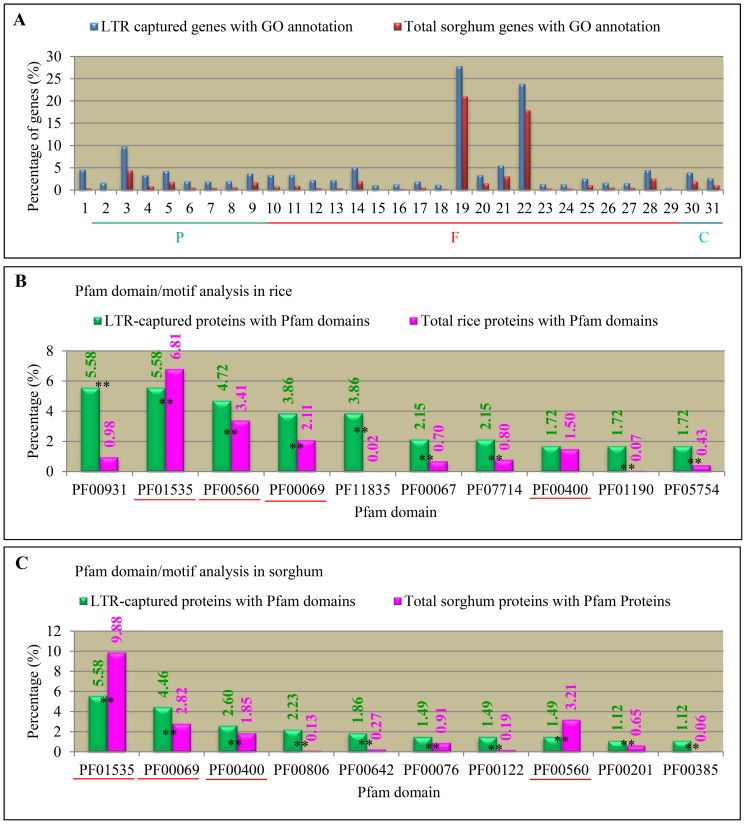
Gene set enrichment analysis and Protein domain analysis in LTR retrotransposon captured genes.(A) Gene set enrichment analysis in sorghum. Blue and red columns indicate the percentages of this GO term in all LTR captured sorghum proteins and in total annotated proteins, respectively. The percentage is calculated as the frequency of the total numbers of each GO term in all LTR captured proteins with GO term assigned or in all annotated proteins with GO term assigned. “P”, “F” and “C” in (A) indicate GO three categories biological process, molecular function and cellular component, respectively. GO term annotation in (A) was shown below: 1, DNA integration; 2, reproductive cellular process; 3, DNA metabolic process; 4, RNA-dependent DNA replication; 5, DNA replication; 6, multicellular organism reproduction; 7, reproductive process in a multicellular organism; 8, chromatin assembly or disassembly; 9, chromatin organization; 10, RNA-directed DNA polymerase activity; 11, DNA polymerase activity; 12, aspartic-type endopeptidase activity; 13, aspartic-type peptidase activity; 14, nucleotidyltransferase activity; 15, ribonuclease H activity; 16, endonuclease activity, active with either ribo- or deoxyribonucleic acids and producing 5′-phosphomonoesters; 17, chromatin binding; 18, endoribonuclease activity, producing 5′-phosphomonoesters; 19, nucleic acid binding; 20, endopeptidase activity; 21, peptidase activity; 22, hydrolase activity; 23, di-, tri-valent inorganic cation transmembrane transporter activity; 24, endoribonuclease activity; 25, nuclease activity; 26, endonuclease activity; 27, ribonuclease activity; 28, peptidase activity, acting on L-amino acid peptides; 29, zinc ion transmembrane transporter activity; 30, chromosomal part; 31, chromatin. (B) and (C) Pfam domain/motif analysis in rice and sorghum, respectively. Green and pink columns indicate the percentages of this domain in the LTR captured protein and in total proteins, respectively. Commonly detected over- or under- represented domains in rice and sorghum are highlighted with pink lines. Two stars indicate statistically significant differences at P value <0.01. PF00067, oxidoreductase activity, acting on paired donors, with incorporation or reduction of molecular oxygen; PF00069, protein phosphorylation; PF00076, nucleic acid binding; PF00122, nucleotide binding; PF00201, transferase activity, transferring hexosyl groups; PF00385, ‘chromo’ (CHRromatin Organisation MOdifier) domain; PF00400, WD domain, G-beta repeat; PF00560, protein binding; PF00642, nucleic acid binding; PF00806, RNA binding; PF00931, apoptosis; PF01190, Pollen proteins Ole e I like; PF01535, PPR repeat; PF05754, Domain of unknown function (DUF834); PF07714, protein phosphorylation; PF11835, Domain of unknown function (DUF3355.